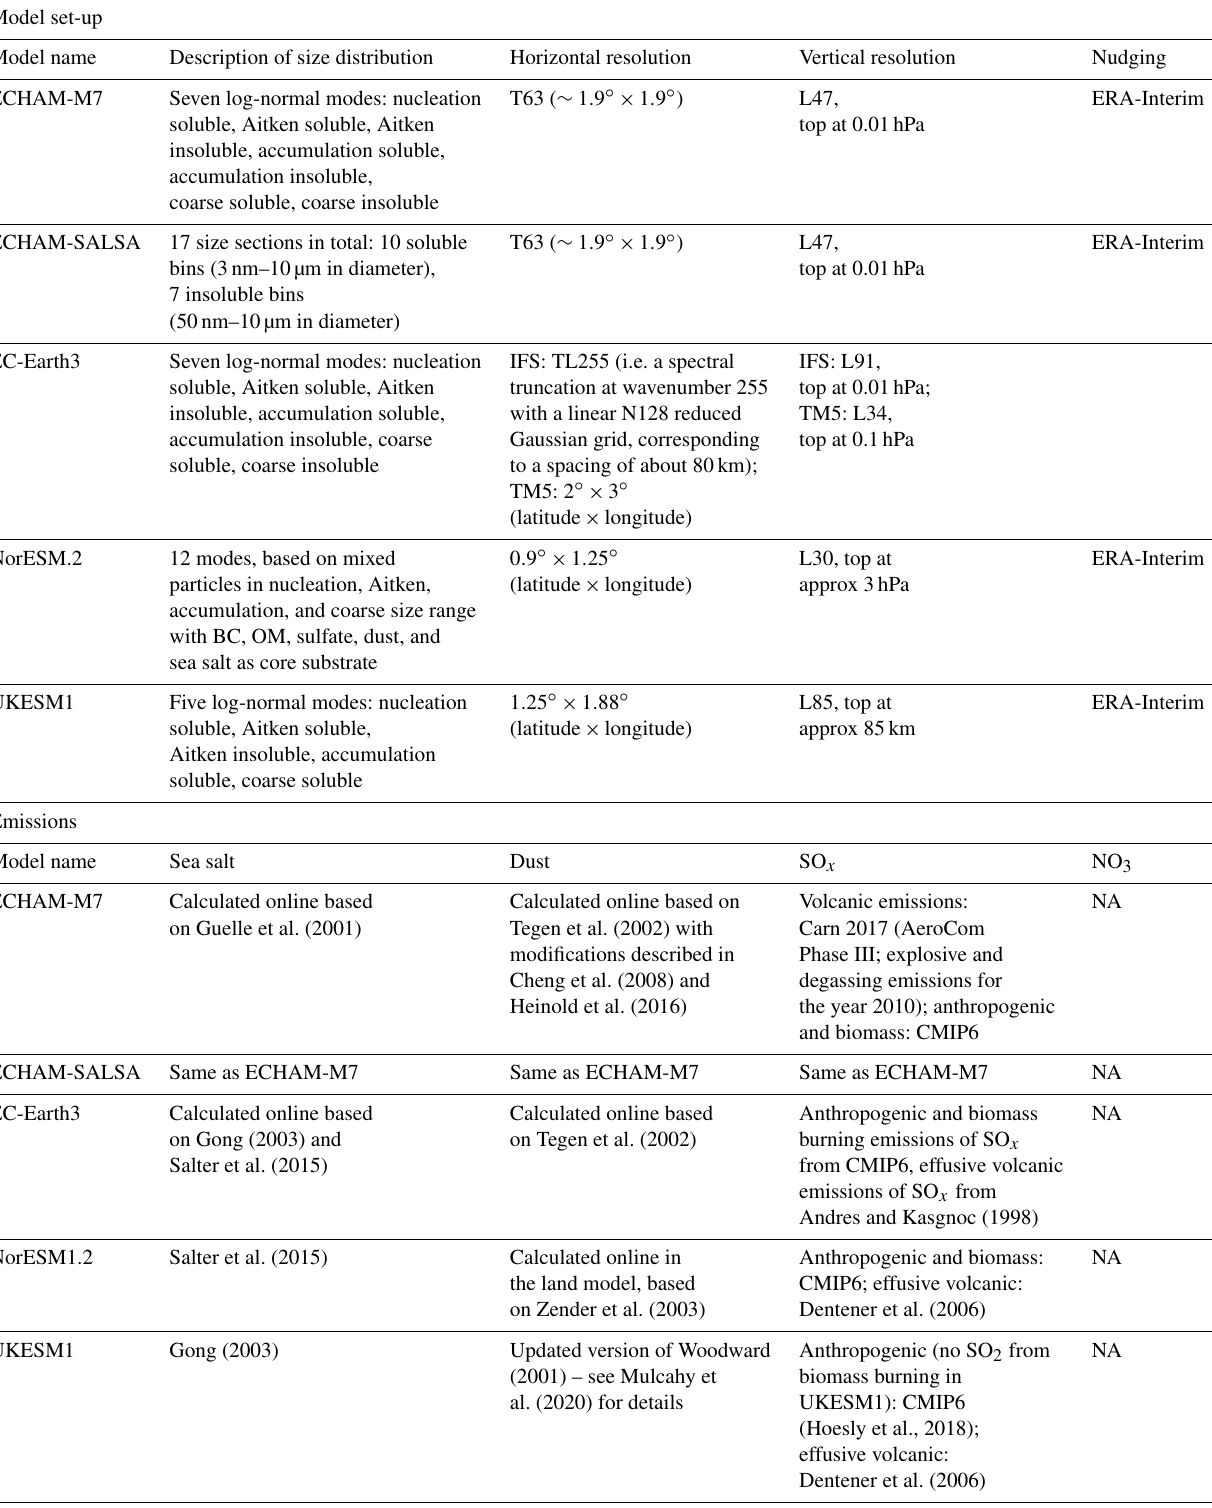
Table 3. Summary of model set-up, emissions, and aerosol microphysics in five climate models used in this study. Model